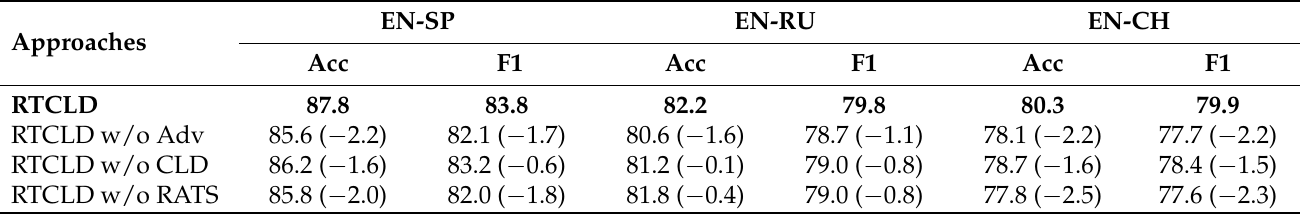
Table 3. The results of ablation studies. The best scores are shown in bold.